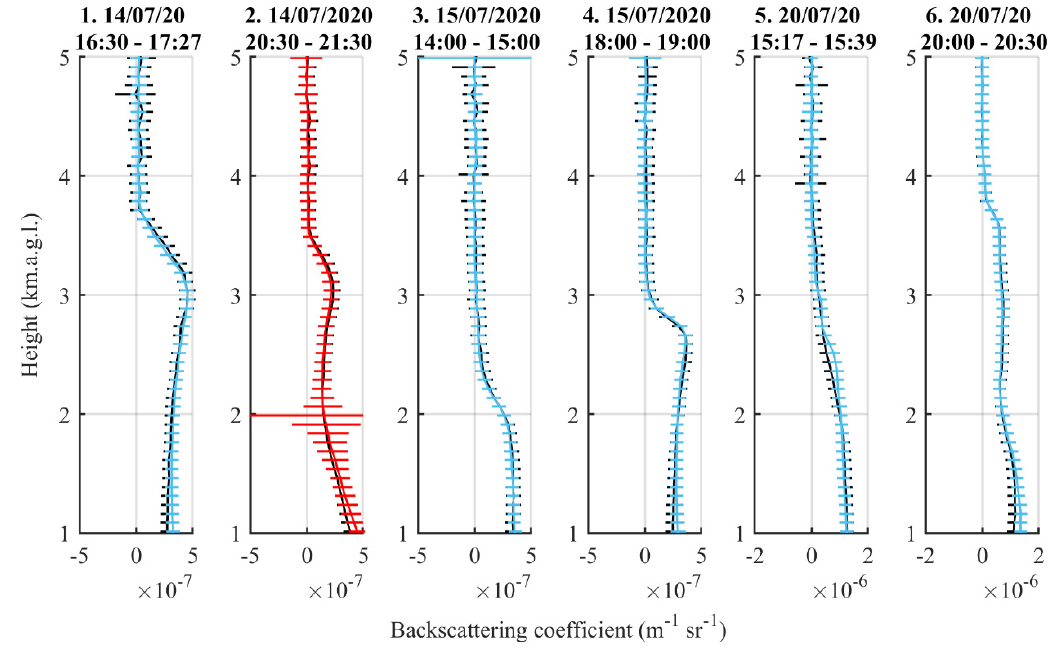
Figure 2. Lidar (red and blue lines) and ceilometer (black lines) backscattering coefficient profiles for the 6 cases detailed above. The case marked in red do not fulfill the NMB and R criteria. Errors bars in Lidar and ceilometer profiles have been estimated using the Monte Carlo method [21].